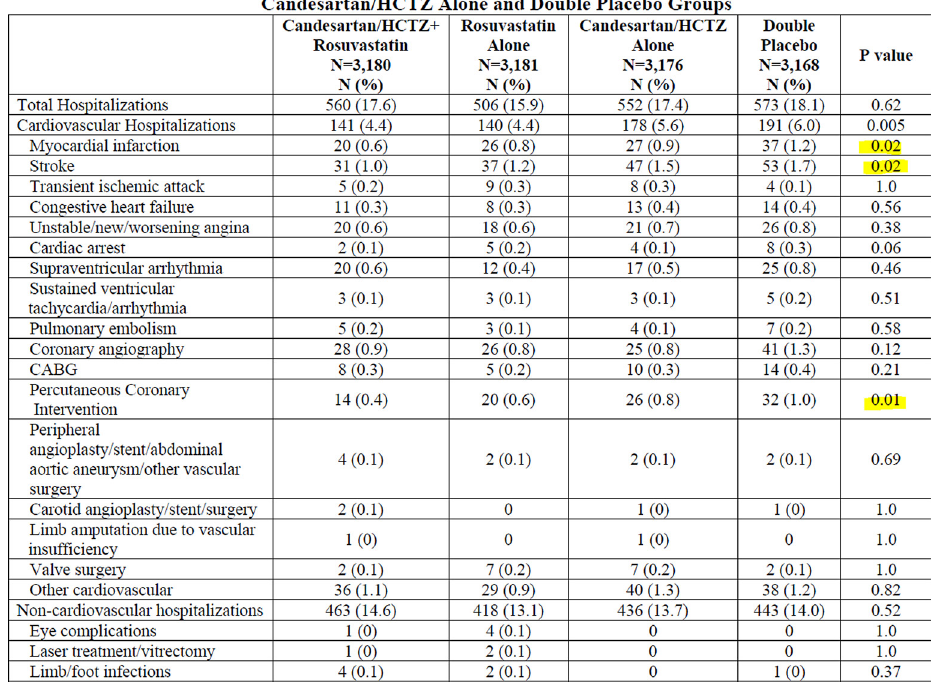
Figure 1. First table (despite being number 20) in the Supplementary materials showing the four groups randomized in HOPE-3. (Figure reproduced under license from the original